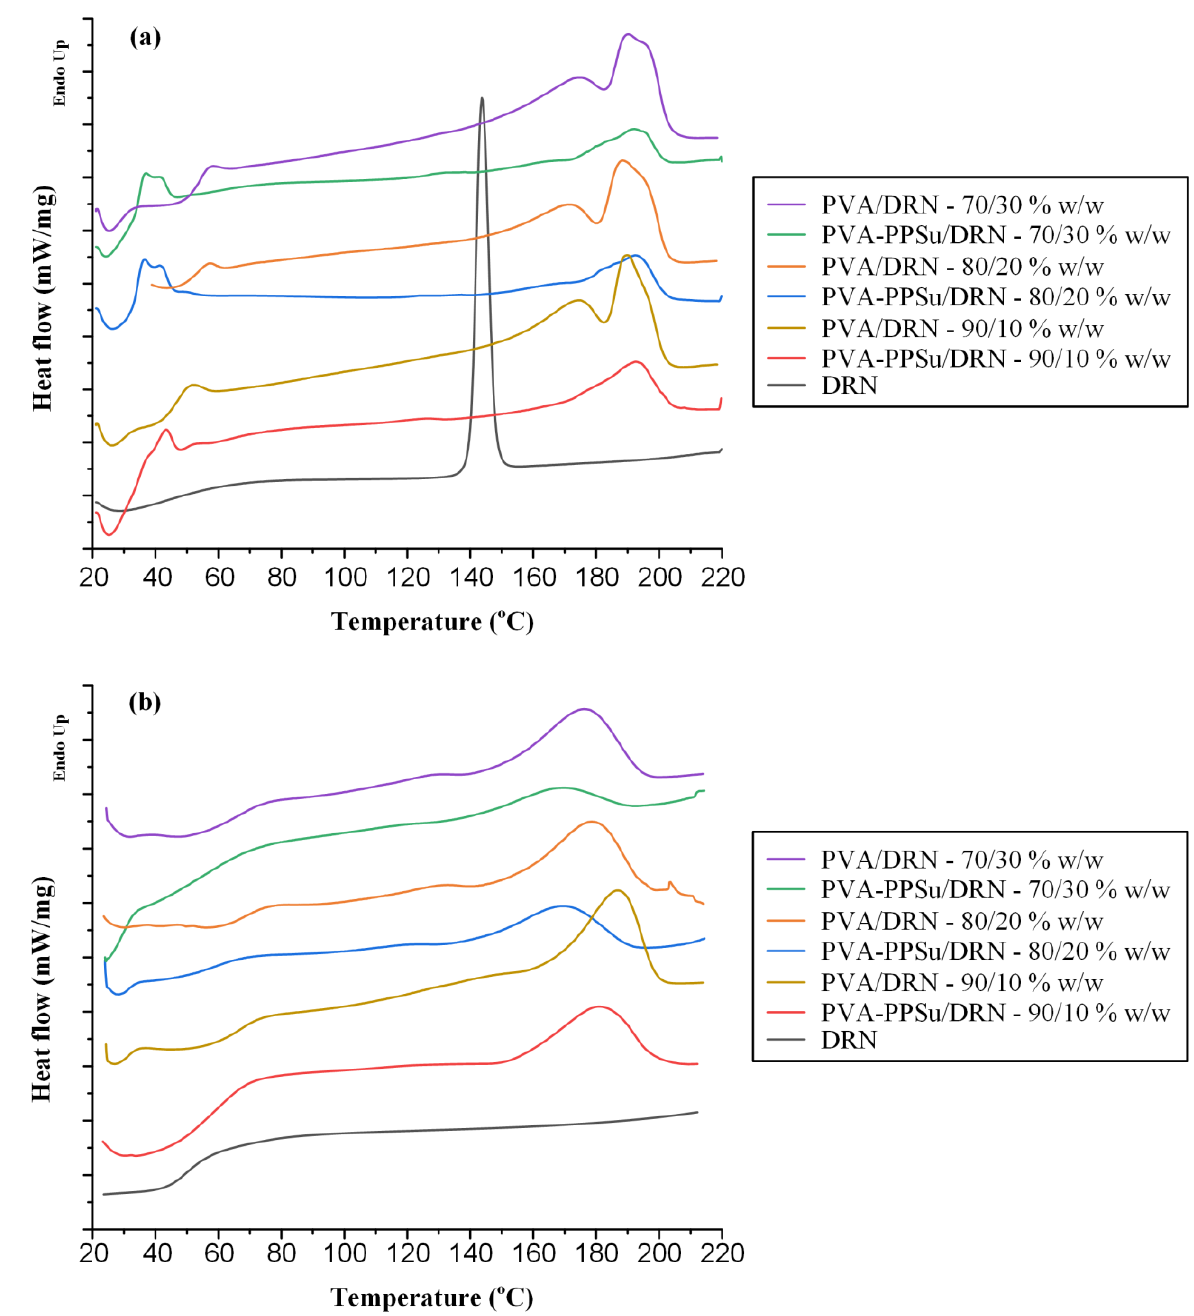
Figure 10. DSC thermograms after the 1st ( a ) and the 2nd ( b ) heating scans for the DRN-loaded ASDs.